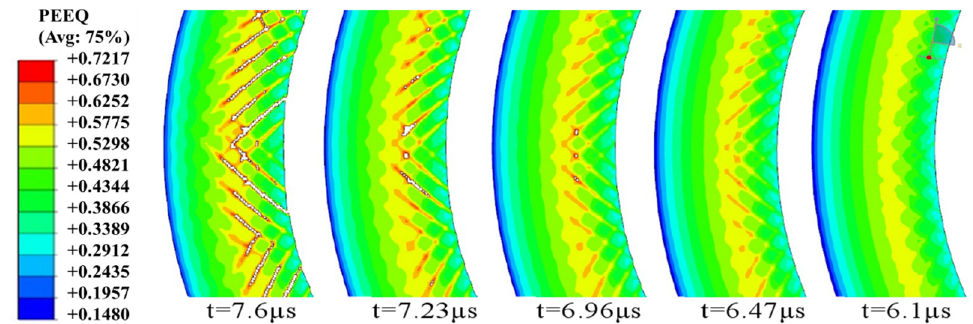
Figure 11. Time − history diagram of shell failure under 41.6 g TNT.